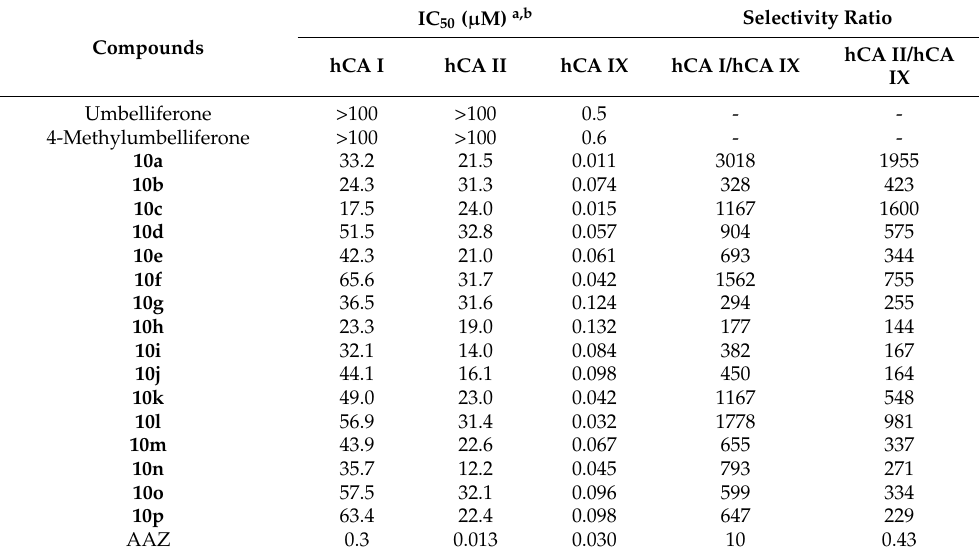
Table 3. The inhibitory data of hCA I, hCA II and hCA IX with the compounds ( 10a – 10p ) by the esterase